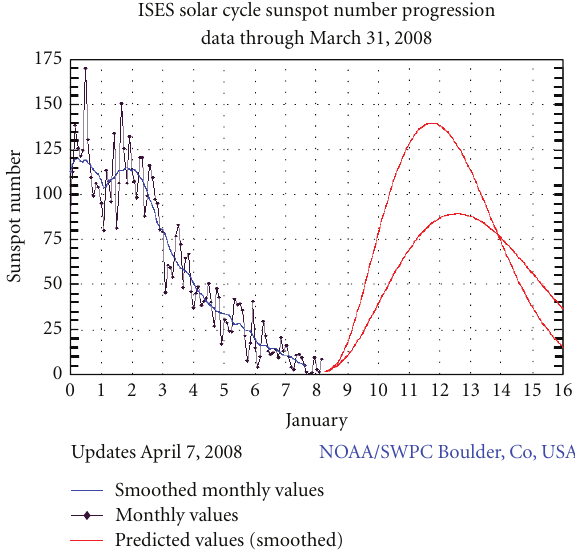
Figure 8: The first international consensus in SC24 prediction da- ted April 7, 2008 (http://www.swpc.noaa.gov/SolarCycle/SC24/in- dex.html).